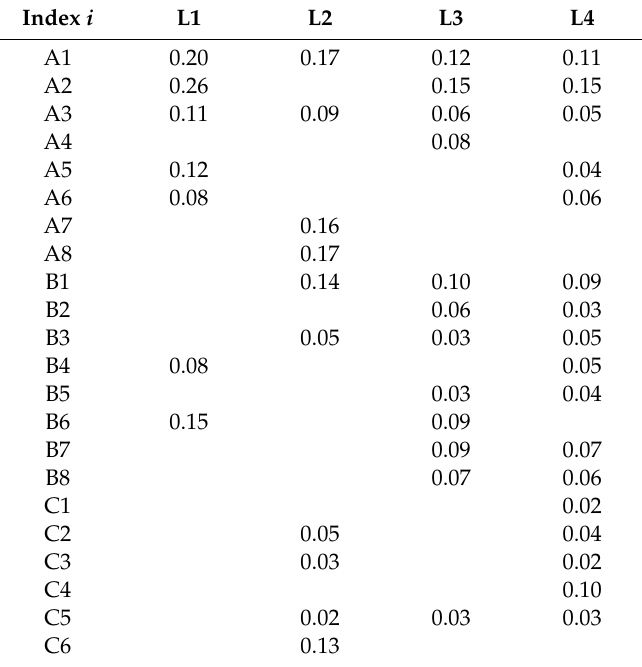
Table 5. The combined weights of each